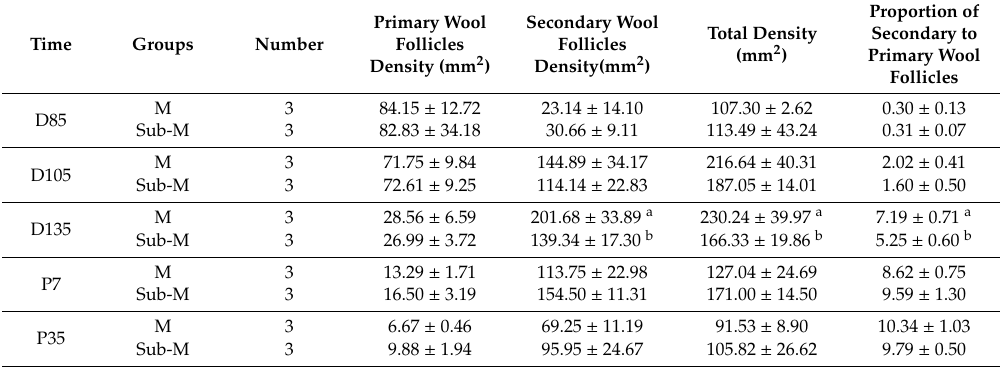
Data are means ± SD, a,b Within column, different superscript letter indicates differences ( p < 0.05) between M and Sub-M group at the same gestation stages.